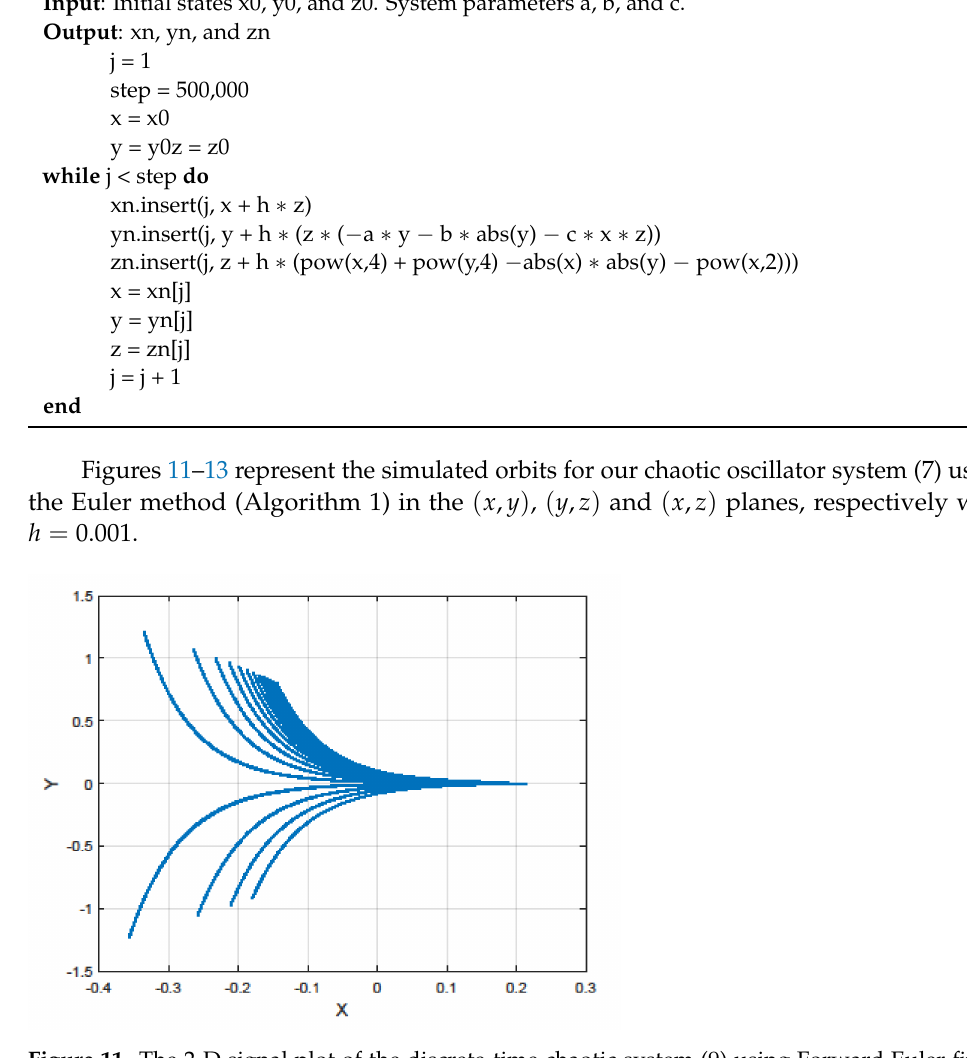
Figure 11. The 2-D signal plot of the discrete-time chaotic system (9) using Forward Euler finite- difference scheme in the ( x , y )